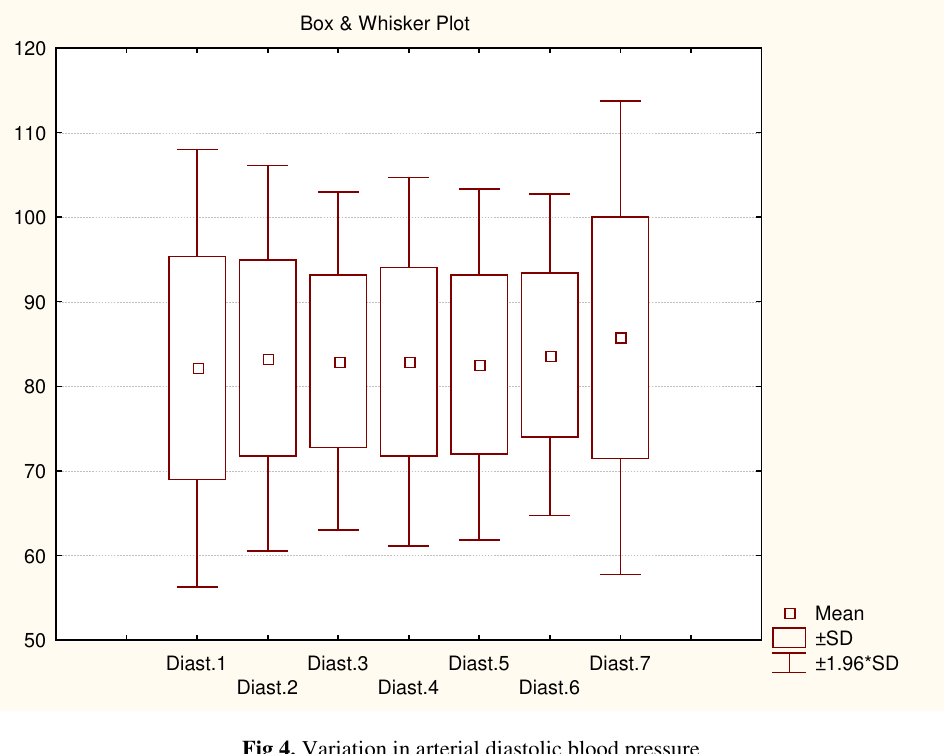
Fig 4. Variation in arterial diastolic blood pressure